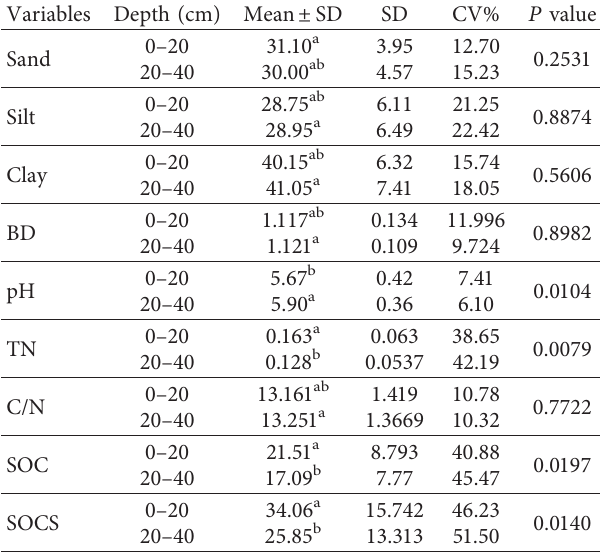
Table 2: Means differences of the selected soil properties between the two depths.